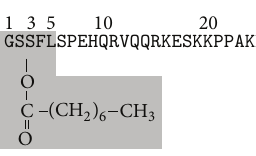
Figure 3: Minimal active core sequence of ghrelin required for GHS-R1A activation. The highlighted box indicates the minimal active N-terminal pentapeptide core of ghrelin sequence required for GHS-R1A